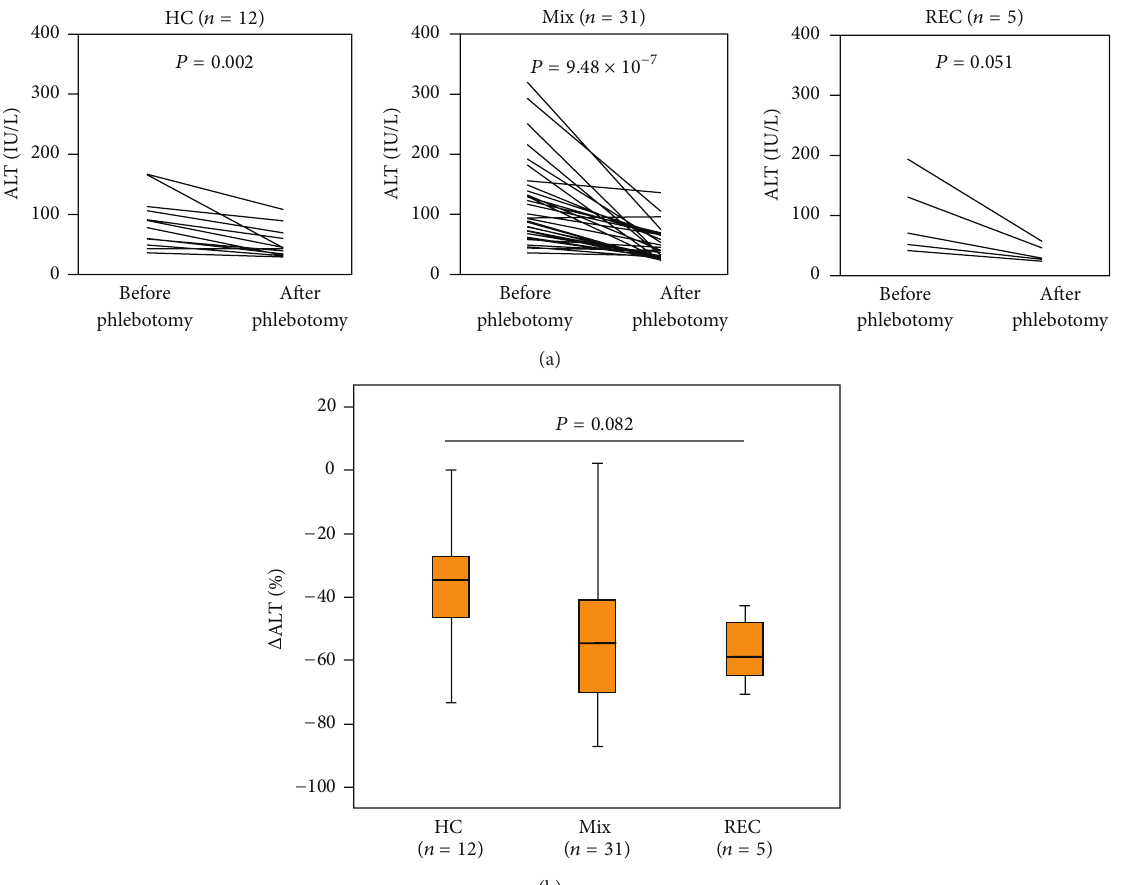
Figure3:Linegraphs(a)showthealanineaminotransferase(ALT)levelsbeforeandafterphlebotomy.DifferencesinALTlevelswereanalyzed by the Wilcoxon signed-rank test. Box graph (b) shows the percentage change in ALT levels after phlebotomy. Differences among the three groups were analyzed by ANOVA ( 𝑃 = 0.082 ). None: no stainable iron, HC: iron deposition in hepatocytes alone, Mix: iron deposition in mixed hepatocytes/reticuloendothelial cells, and REC: iron deposition in reticuloendothelial cells alone.